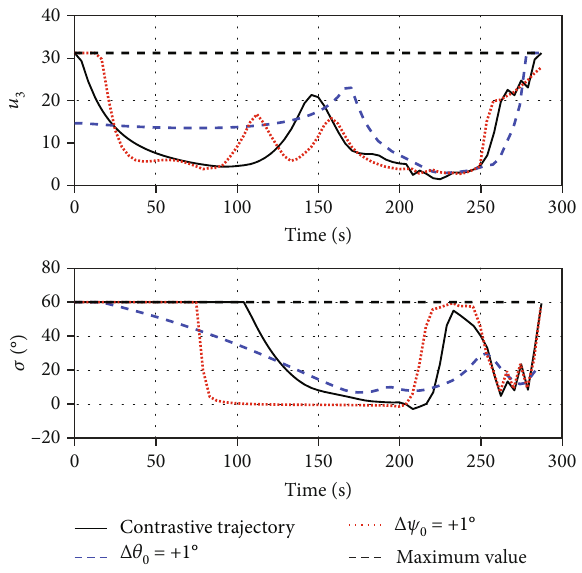
ffiffiffiffiffiffiffiffiffiffiffiffiffiffiffi p 2 L 2 + D 2 e , V H